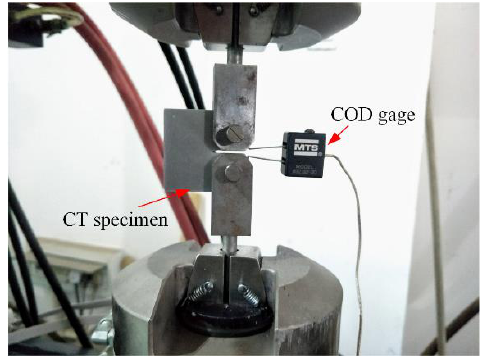
Figure 3. Fatigue crack propagation test with a crack opening displacement (COD) gauge.